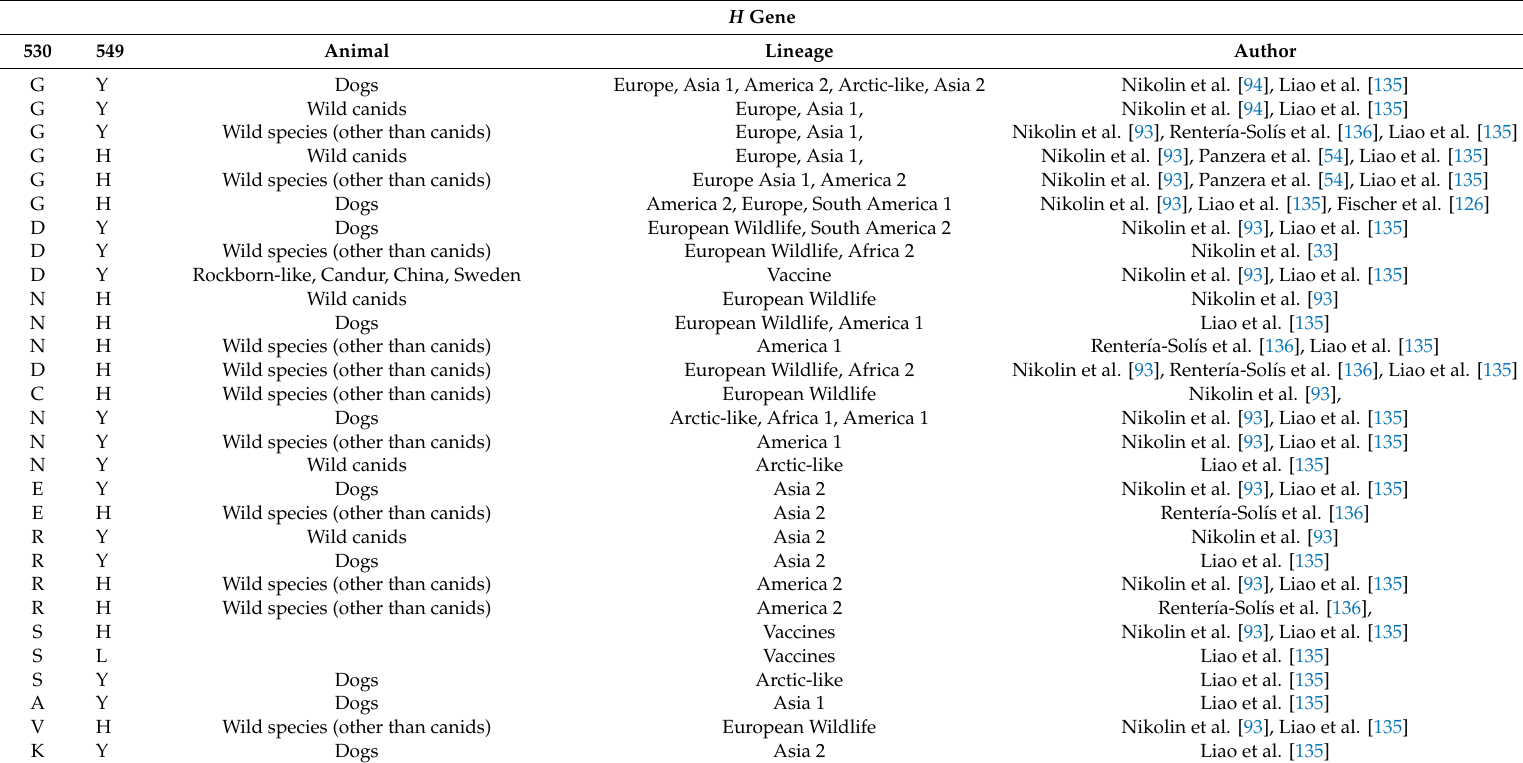
Table 2. Summary of amino acids present at di ff erent positions of the H protein interacting with the SLAM receptor. H